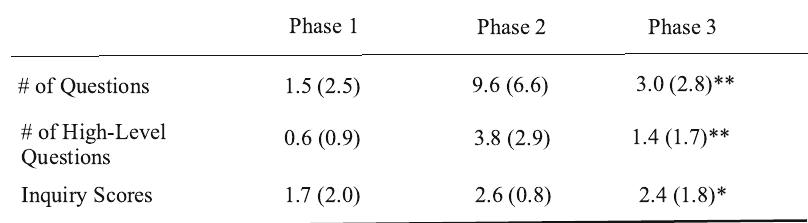
Depth ofInquiry on Knowledge Forum Over Time